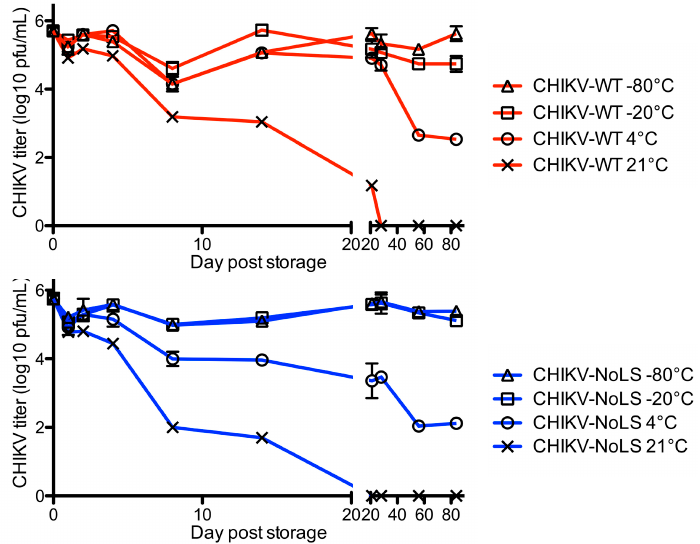
Figure 5. Long term thermostability of CHIKV-NoLS. CHIKV-NoLS and CHIKV-WT were diluted to 5 × 10 5 pfu/ml and vials stored at 21 °C, 4 °C, − 20 °C and − 80 °C. At the indicated time points infectious CHIKV-NoLS and CHIKV-WT was quantified by plaque assay. Each symbol represents the mean ± standard